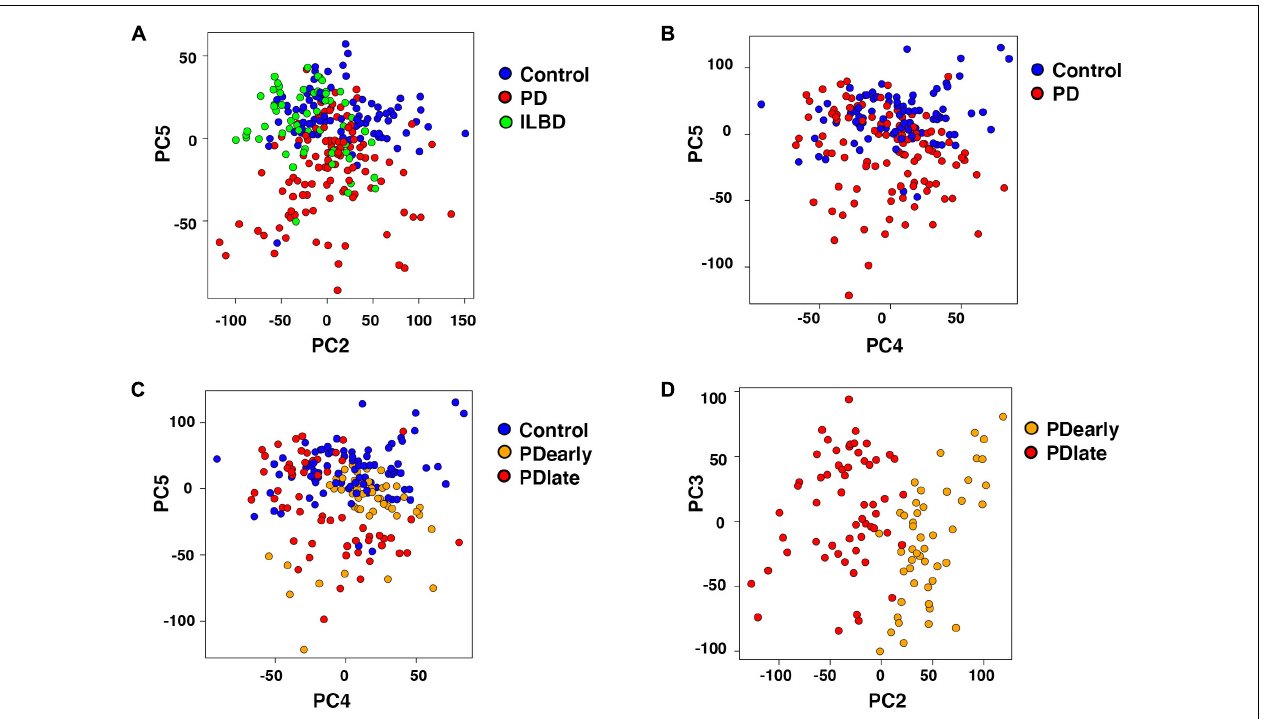
FIGURE 3 | Segregation of Parkinson’s disease samples influenced by disease progression. (A) Two dimensional PCA (PC2, PC5) of Control, Parkinson’s disease and incidental Lewy body disease samples. PC5 separates Parkinson’s disease from Control and incidental Lewy body disease samples. Samples are color-coded by disease. (B,C) Two dimensional PCA (PC4, PC5) of Control and Parkinson’s disease samples. Samples are color-coded by disease (B) and disease duration (C) . PC5 separates Parkinson’s disease from Control samples. (D) Two dimensional PCA (PC2, PC3) of PDearly and PDlate samples. PC2 separates PDlate from PDearly samples. Samples are color-coded by disease